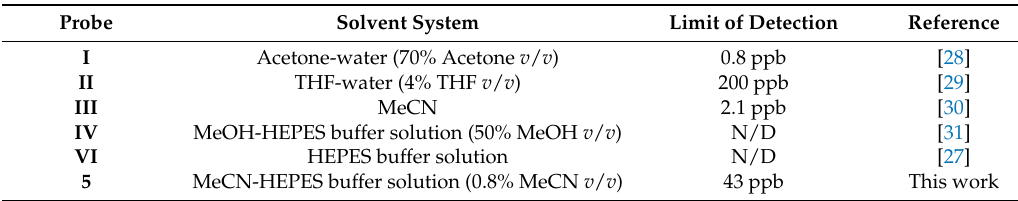
Table 1. Comparison of fluorescent probe 5 with other reported coumarin-based probes used for the detection of fluoride.